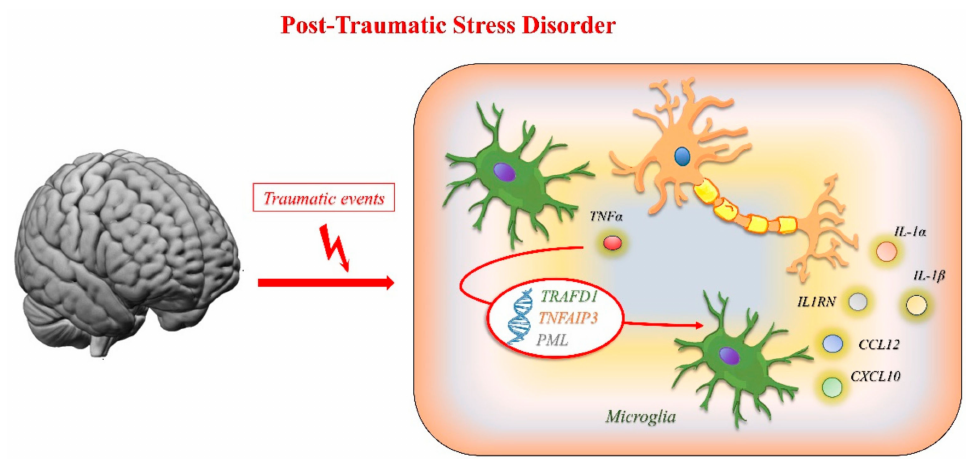
Figure 8. Immunological mechanisms associated with post-traumatic stress